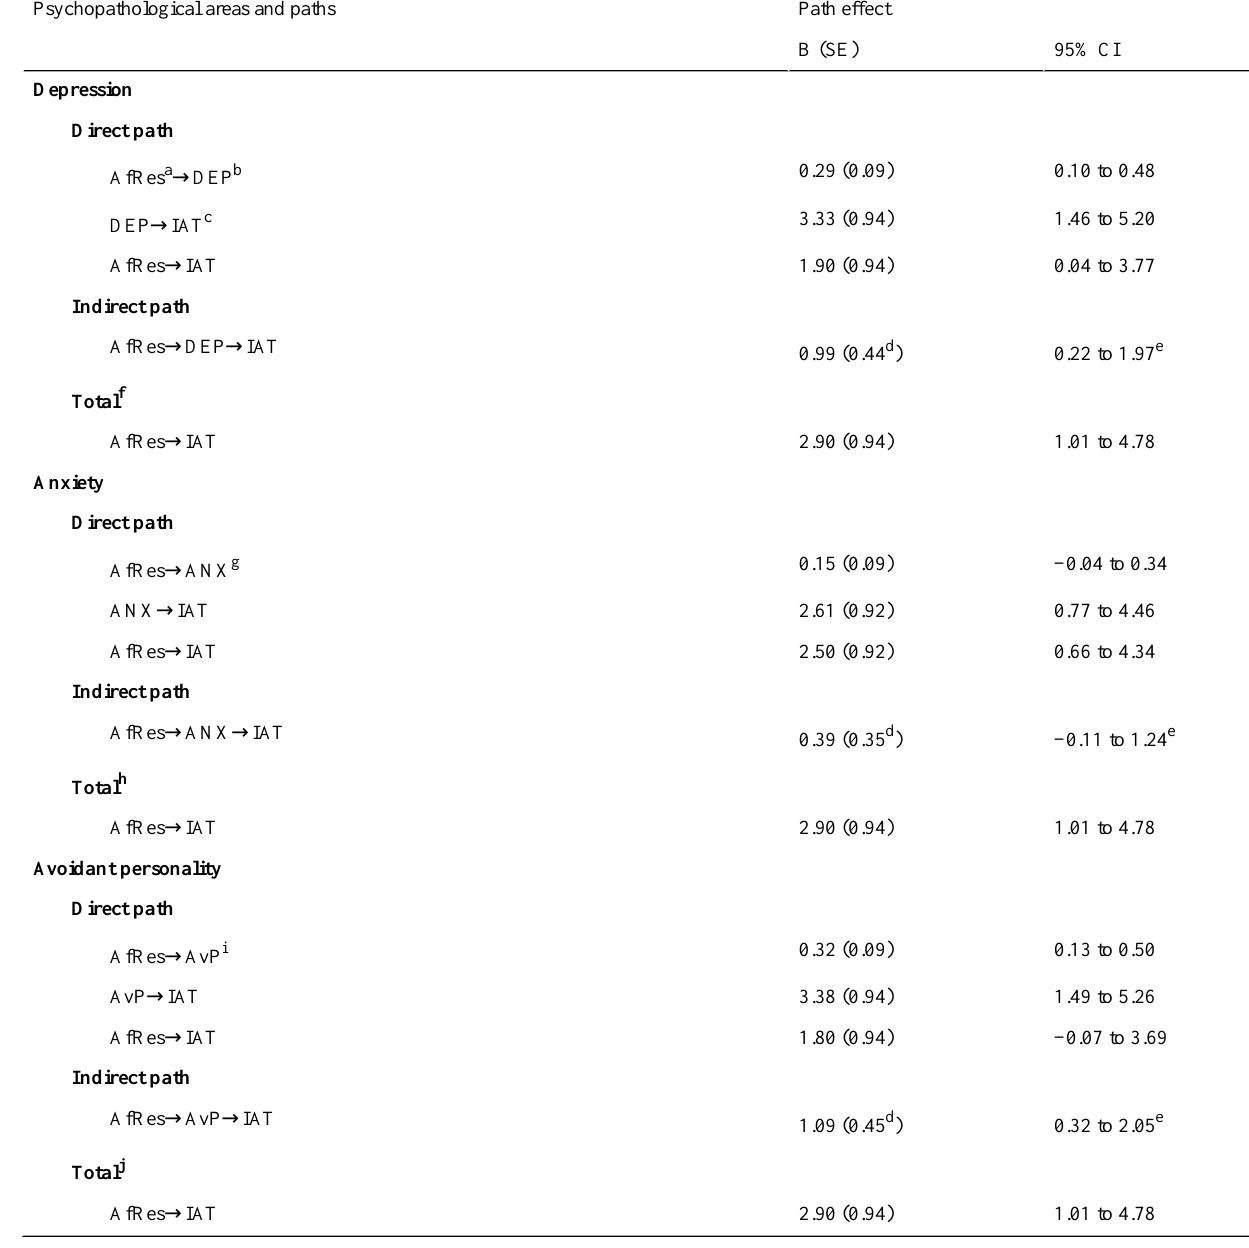
Table 6. Simple mediator models showing total, direct, and indirect effects of affective responsiveness on internet